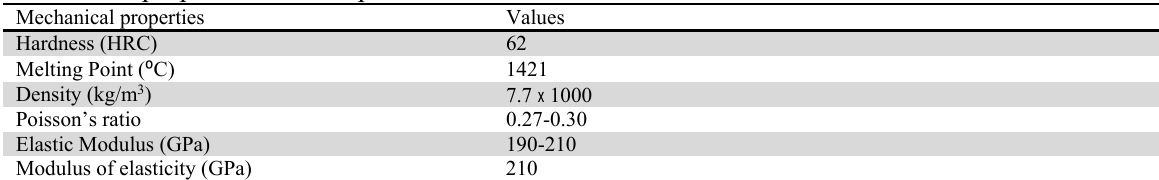
Mechanical properties of workpiece material